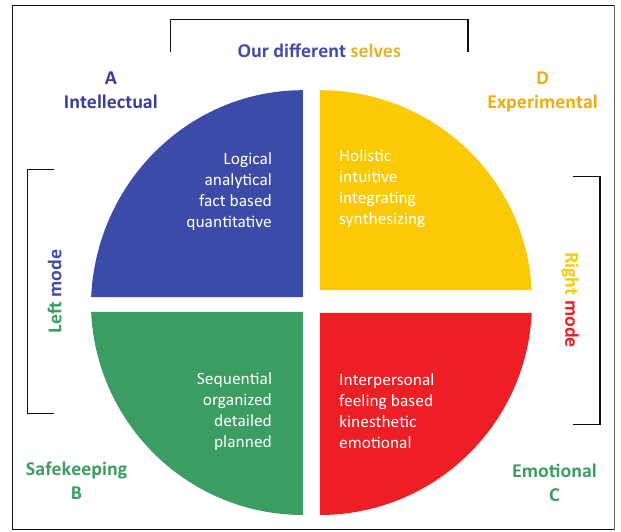
FIGURE 2: Metaphoric whole brain